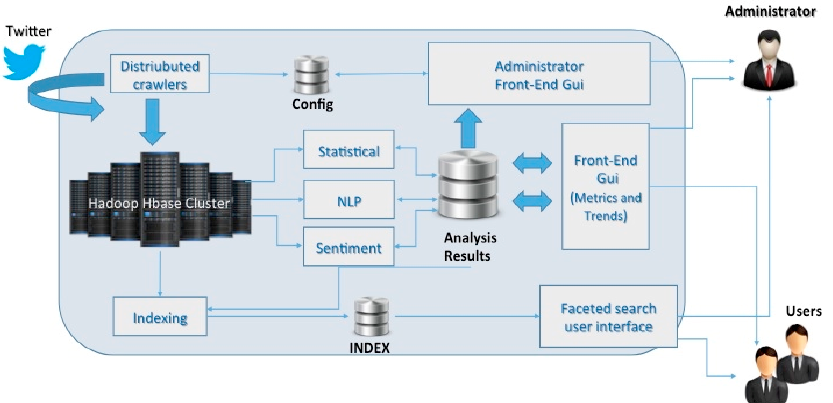
Figure 15. Twitter Vigilance